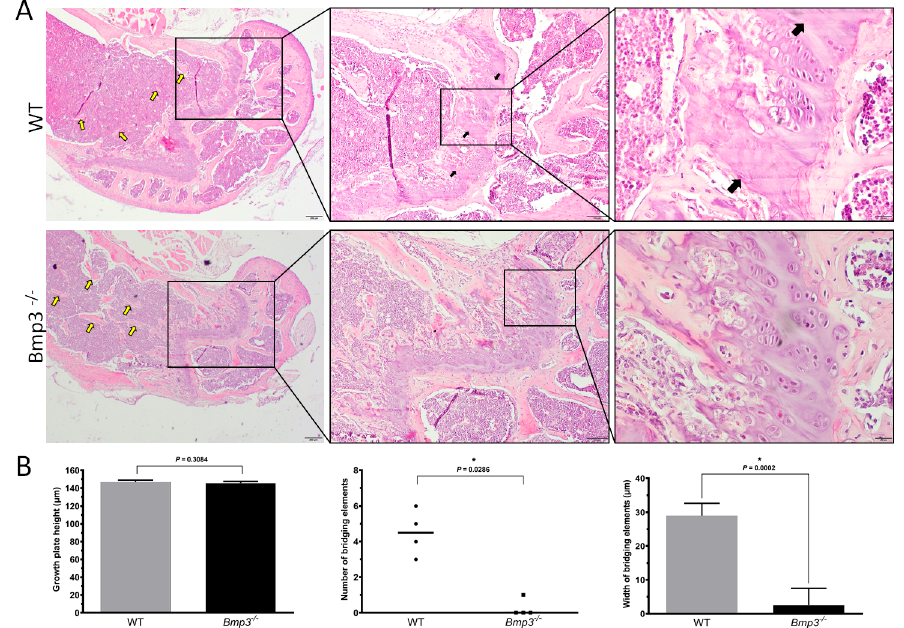
Figure 8. Histology of the mouse femur at 16 weeks of age. The difference in trabecular bone between WT and Bmp3 − / − mice (yellow arrows) is in concordance with the results of micro-CT analysis. Bridging regions of mineralized cartilage in the epiphyseal growth plate were observed in WT mice (black arrows), but not in Bmp3 − / − mice ( A ). No difference in growth plate height was observed between Bmp3 − / − and WT mice. Bridging element regions were significantly decreased in Bmp3 − / − mice ( B ). Statistically significant differences are indicated by